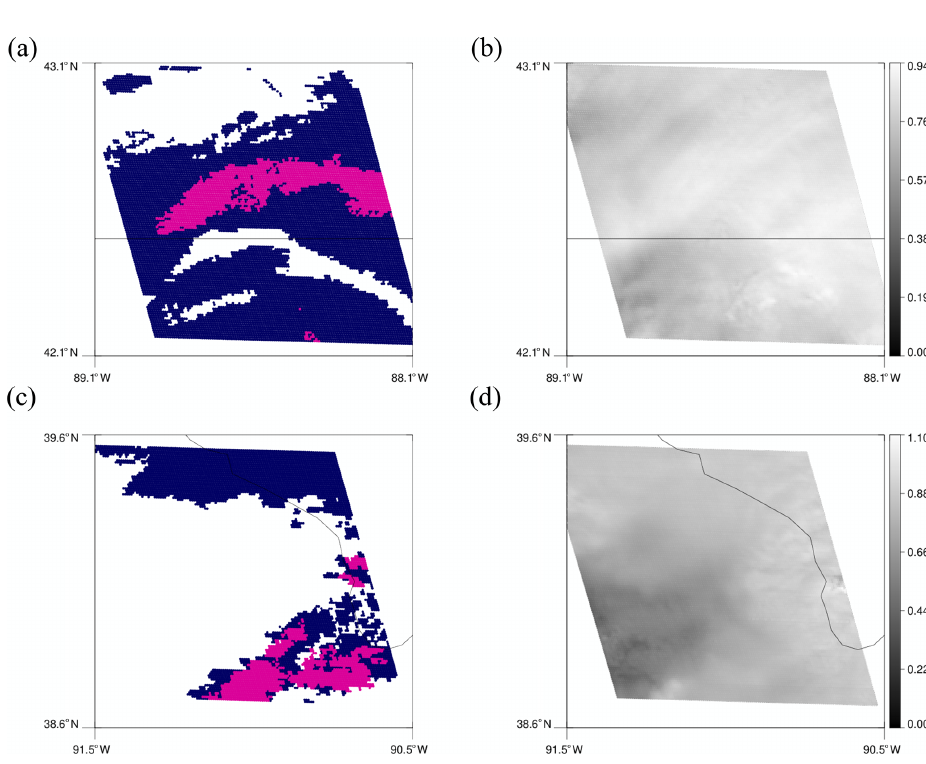
Figure 10. (a) MRMS PrecipFlag and (b) reflectance on channel 2 of the upper red box in Fig. 5b. (c) MRMS PrecipFlag and (d) reflectance on channel 2 of the lower red box in Fig.